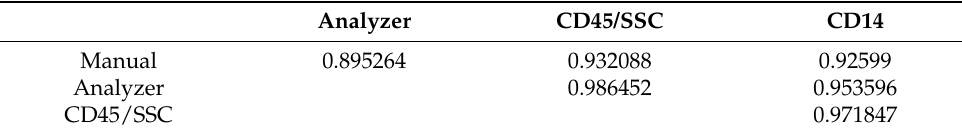
Table 1. Relationship between four most popular methods of monocyte analysis and